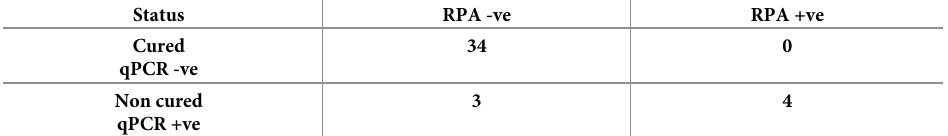
Table 7. Determination of prognostic positive and negative predictive values of RPA vs. qPCR in patients with PKDL following completion of treatment (n = 41). Status RPA -ve RPA +ve Cured qPCR -ve Non cured 3 qPCR +ve Skin biopsies collected from patients with PKDL were evaluated by qPCR and RPA as described in materials and methods following completion of treatment with Miltefosine, either (i) at the end of 12 weeks (n = 8) or (ii) � 6 months after completion of treatment (n = 33). The patients were grouped as (a) cured i.e. qPCR -ve or (b)